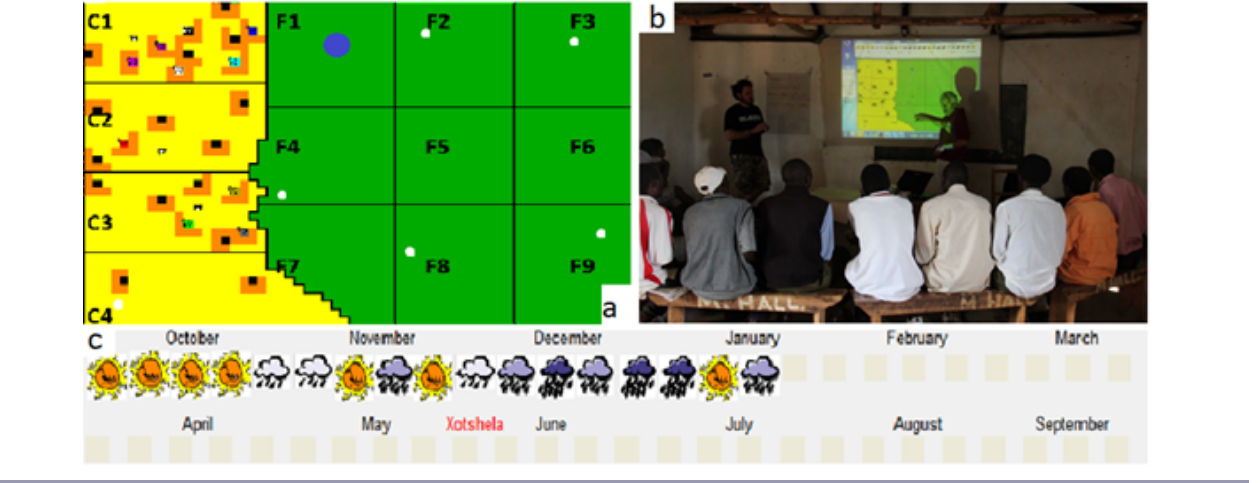
Fig. 3. Description of the prototype version of the role-playing game (V0): virtual environment (a), game setting (b) and rain calendar (c). a. The figure shows the virtual environment. The communal land (yellow) and the forest (green) are respectively composed of four and nine paddocks. Circles represent water pans (blue = filled, white = empty). Each farm is composed of a kraal (black) and five fields (orange). Each farm has a color; each herd has the color of its farm. Computerized farms are black and don’t have any herd. b. The virtual environment was projected on the wall, and players had to come to the computer operator to signify their playing decisions. c. The four types of weekly weather were represented by explicit symbols: a sun for a dry weather with no rain, a light gray cloud for small rainfall, a dark gray cloud for medium rainfall, and a black cloud for heavy